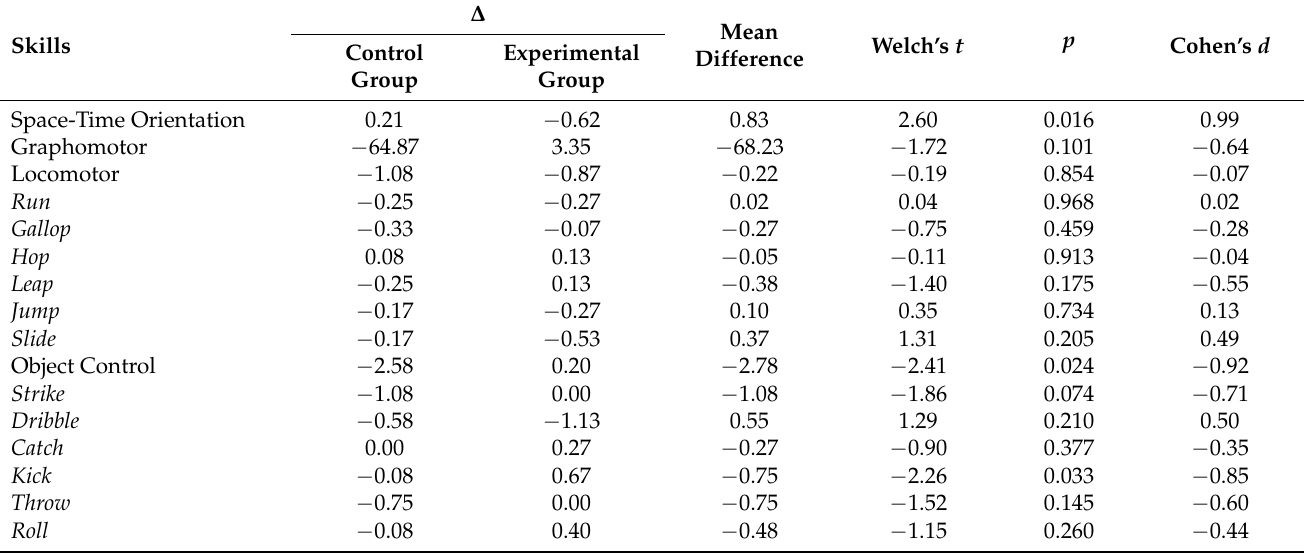
Table 2. Changes between post-test and baseline (pre-test) scores of the control and experimental group and the independent samples t -test